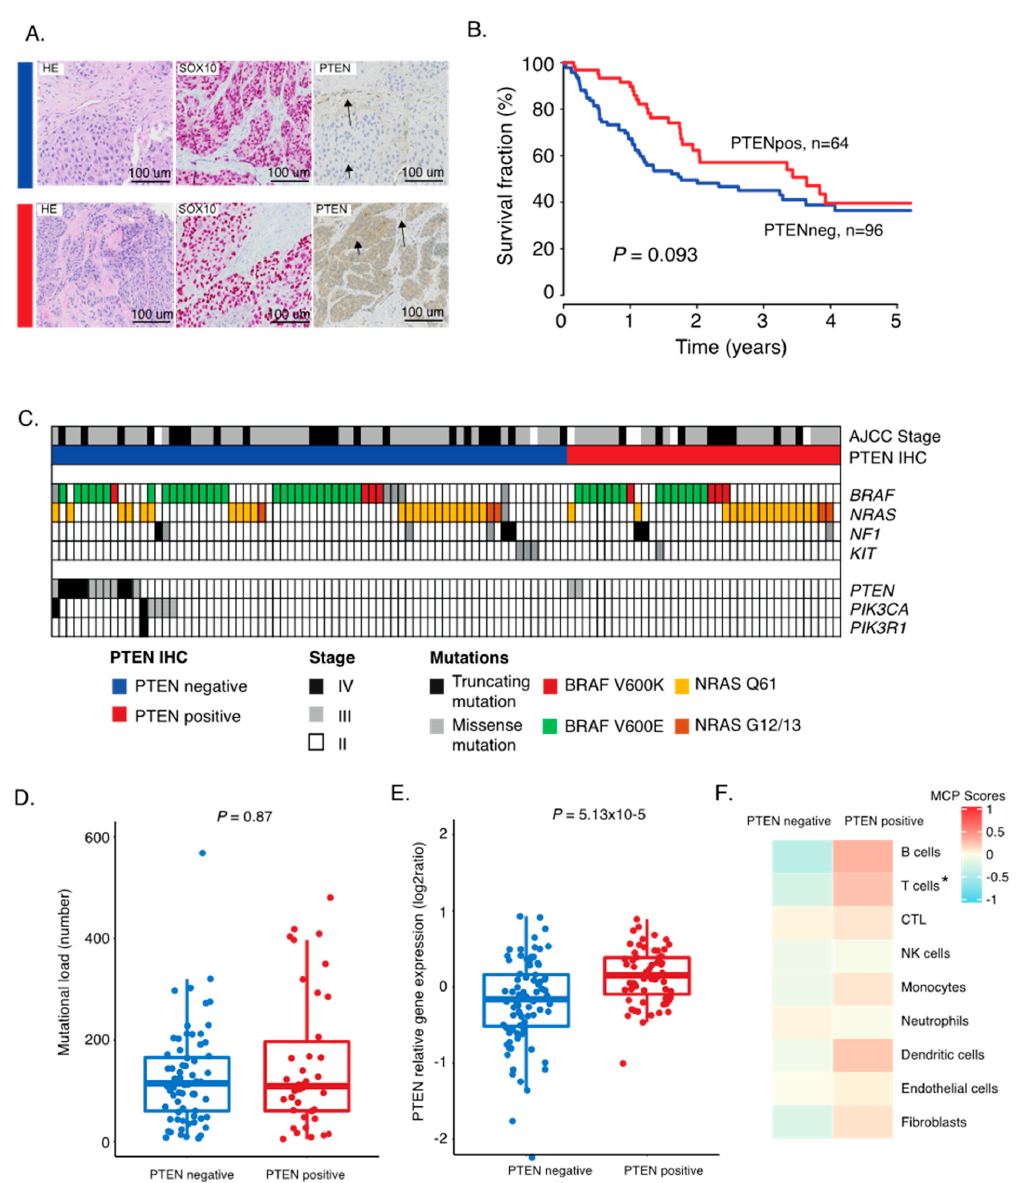
Figure 1. Characterization of PTEN expression groups in melanoma tumors. ( A ) Immunostaining of HE, SOX10, and PTEN on tissue microarray representative cores. Sections were taken consecutively. A PTEN-negative case and a PTEN-positive case are shown. Arrowheads indicate tumor cells, and arrows indicate non-tumor cells. ( B ) Kaplan–Meier survival analysis using log-rank tests of PTEN. ( C ) Mutational pattern of representative genes of the MAPK and PI3K pathways in PTEN-positive and -negative tumors. Twelve tumors in the PTEN negative group had PTEN mutation; six cases had PIK3CA mutation; and one harbored PIK3R1 mutation. Among the PTEN-positive tumors, only two PTEN mutated tumors were found. ( D ) Mutational load across PTEN grouping. ( E ) Boxplot of gene expression of the PTEN gene between PTEN-positive and -negative tumors. p -values in boxplots were calculated using Wilcoxon analysis. ( F ) Average microenvironment cell populations (MCP) in PTEN-positive and PTEN-negative groups displayed in a heatmap. * FDR < 0.05. All others were